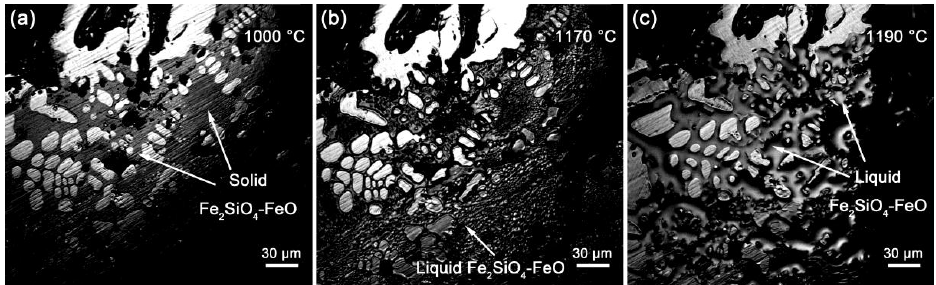
Figure 2. In situ observation of the melting process of Fe 2 SiO 4 –FeO: ( a ) 1000 °C, before melting; ( b ) 1170 °C, at the start of melting; ( c ) 1190 °C, after melting.